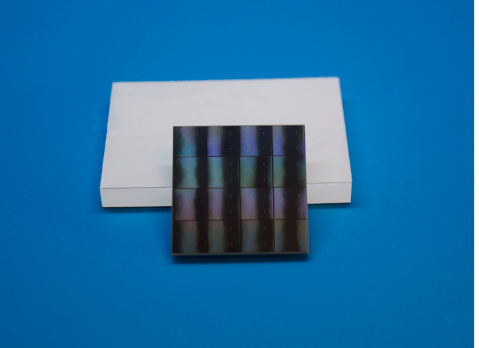
Figure 6. The S13361-6050NE-04 MPPC series manufacturer by Hamamatsu: the device consists of 16 independent cells, each one of 6 mm × 6 mm sensitive area. Narrower spectral responses are typical of PMTs instead: the Hamamatsu R11265-200 (in Figure 7) is sensitive to 300–650 nm, with maximum sensitivity at 400 nm.